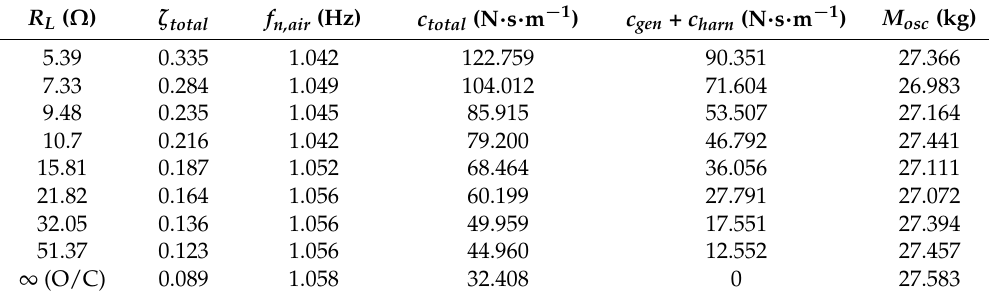
Table 3. Free decay test results.